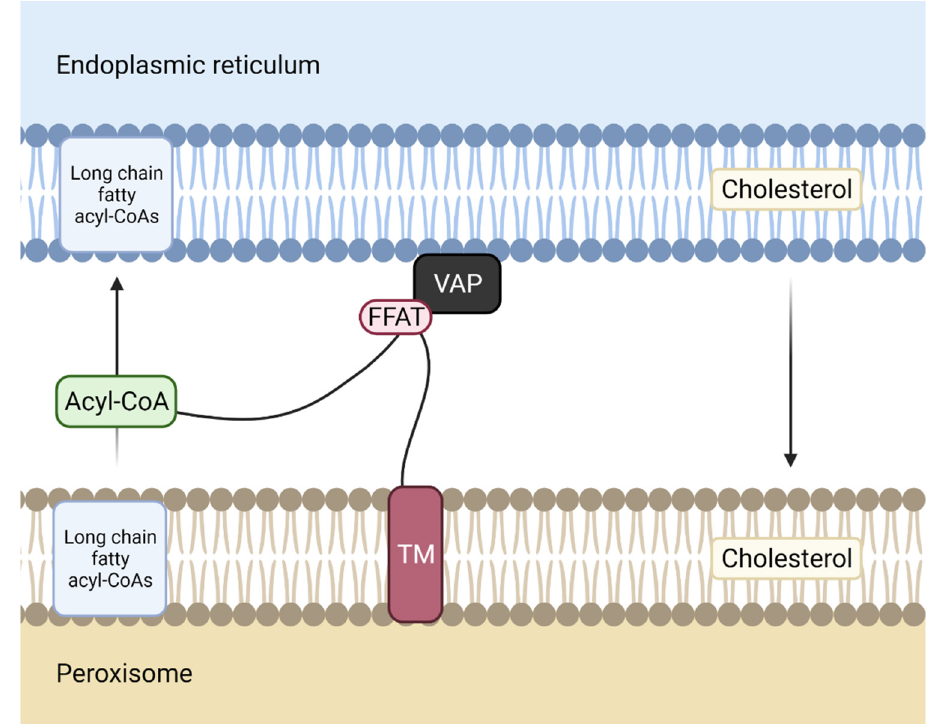
Figure 4. Membrane contact site between the ER and the peroxisome. Acyl ‐ CoA binding domain ‐ containing 5 ACBD5, a protein anchored to peroxisome membrane through its transmembrane do ‐ main (TM), interacts with vesicle ‐ associated membrane protein ‐ associated protein (VAP), an endo ‐ plasmic reticulum (ER) membrane protein, via its two phenylalanines (FF) in an acidic tract (FFAT) ‐ like motif. The Acyl ‐ CoA domain of ACBD5 transports long ‐ chain fatty acyl ‐ CoAs from the ER to the peroxisome.